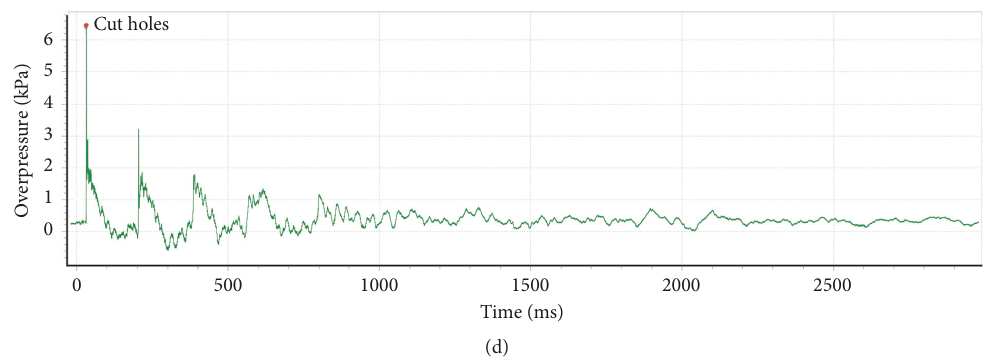
Table 2: Overpressure in the tunnel induced by blasting.